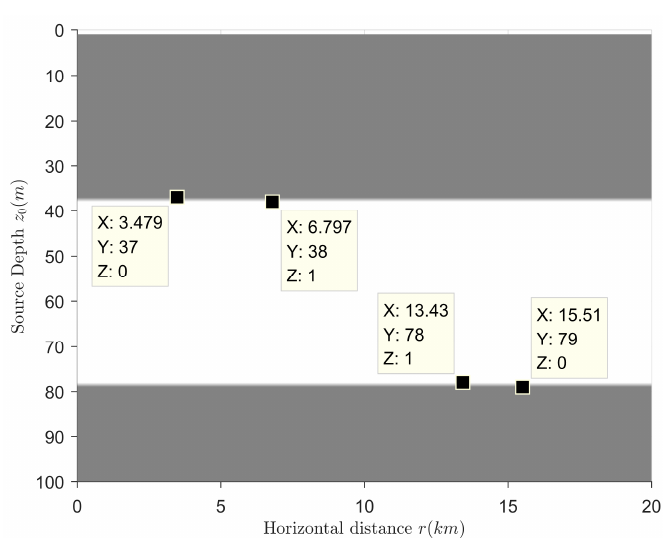
Figure 4. The sign distribution of I zR ( r , z ) . Sensors 2018 , 18 , x FOR PEER REVIEW 11 of 18